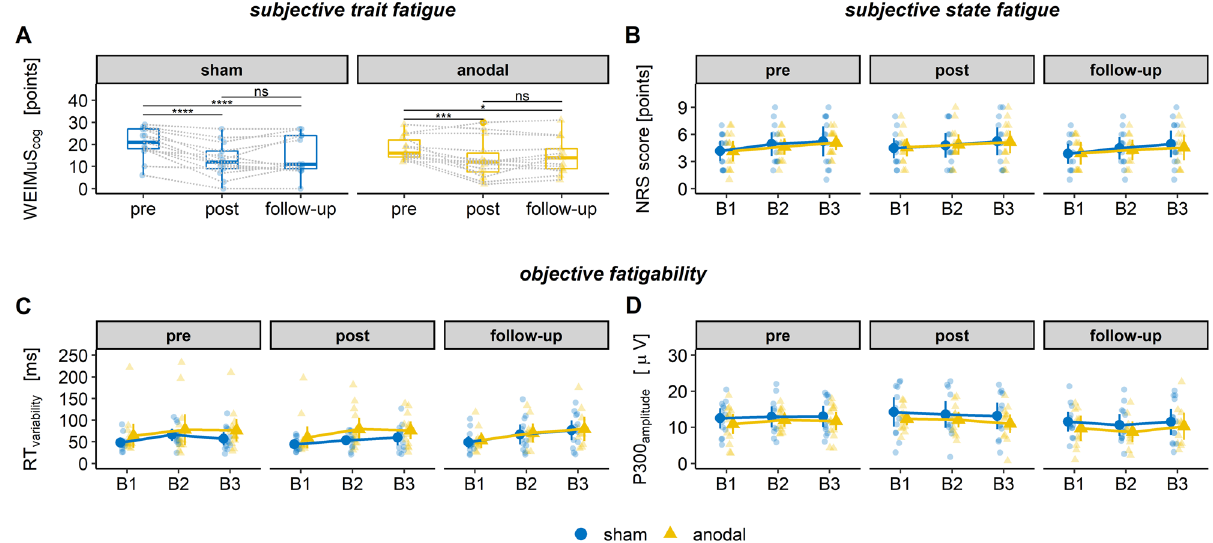
Figure 3. tDCS effects on fatigue and fatigability parameters. ( A ) WEIMuS cognitive scores as a function of session (pre, post, follow-up) separate for sham and anodal group. ( B – D ) Changes in numerical rating scores (NRS, B ), reaction time variability (RT variability, C ), and P300 amplitudes ( D ) as a function of block (B1, B2 and B3) (mean ±